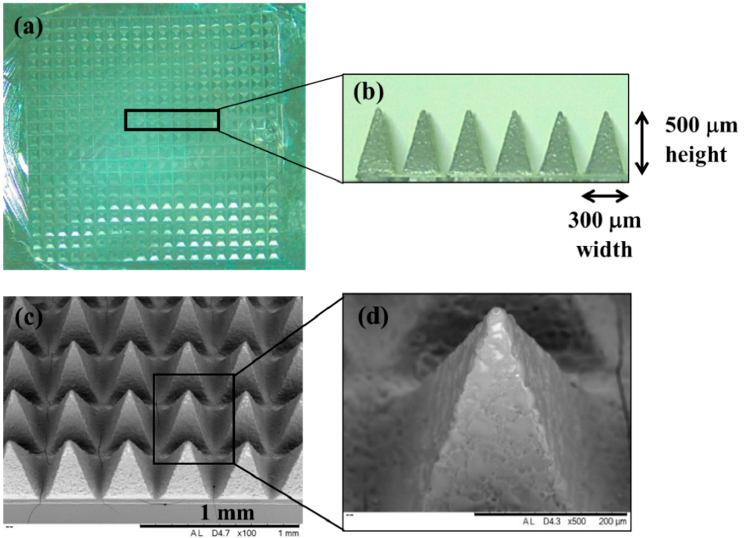
Figure 1. Representative images of Gantrez ® AN119 dissolving microneedles (MNs) arrays. ( a ) Digital images of a complete MN array 500 µ m in height and 300 µ m in width and ( b ) single row of the array. ( c ) Scanning electron microscopy image of an array section with pyramidal shape, and ( d ) individual needle with sharp tip.